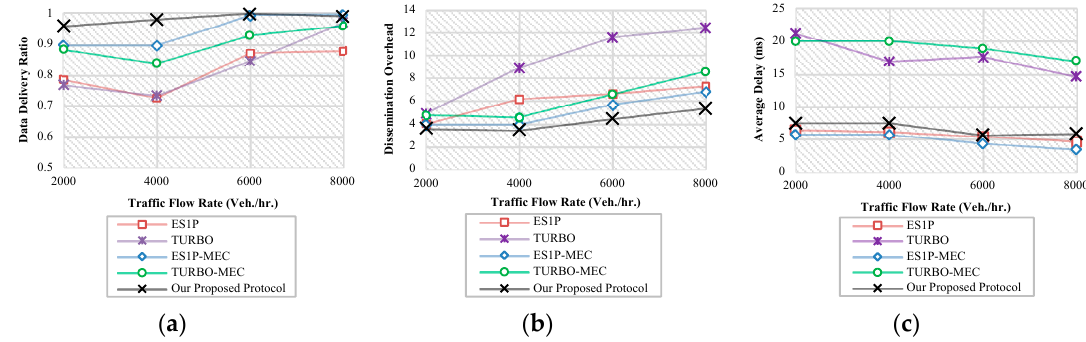
Figure 6. Simulation Results ( a ) Data Delivery Ratio; ( b ) Dissemination Overhead; ( c ) Dissemination